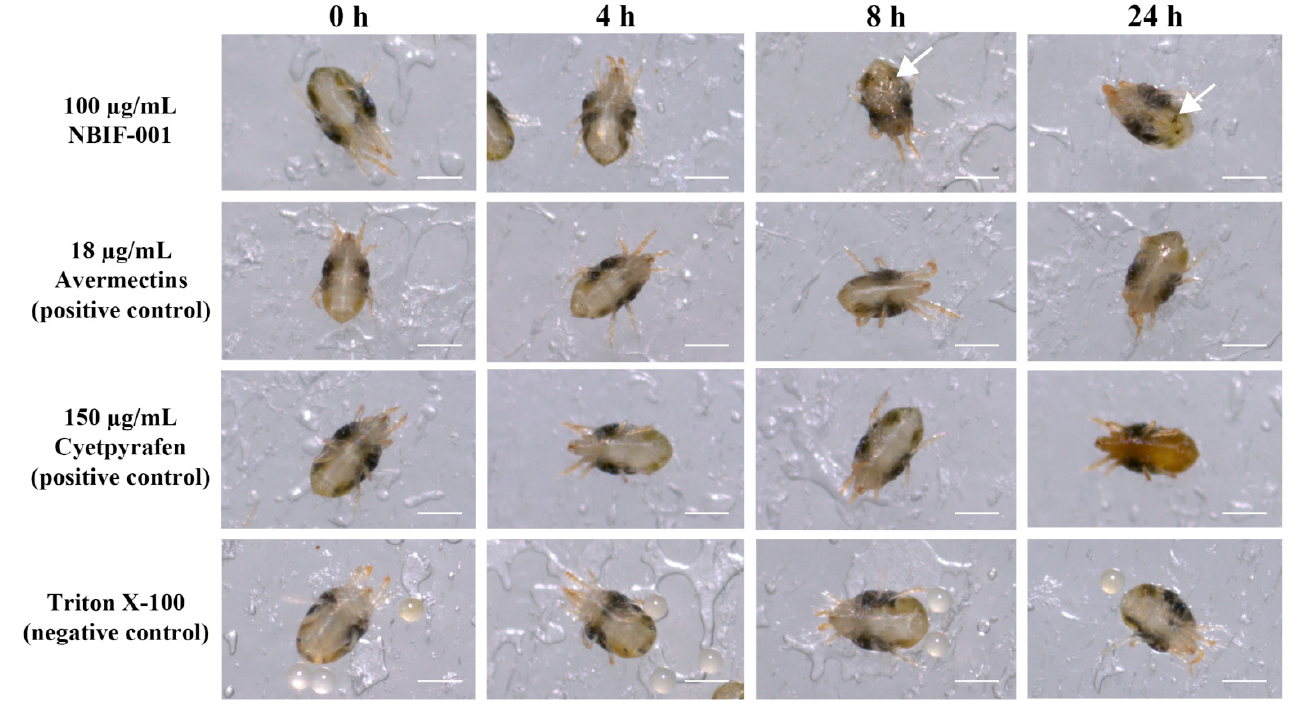
Figure 1. Female adult Tetranychus urticae (green) treated with 100.0 µ g/mL of NBIF-001 culture re-suspension, 18.0 µ g/mL avermectins, 150.0 µ g/mL cyetpyrafen (positive controls), and 0.05% Triton X-100 (negative control) for 24 h. Approximately 120 active adult mites were used for each individual treatment. Bars represent 250 µ m. Arrows indicate signs of body dehydration. Table 2. Acaricidal activity of fermentation-optimised Bacillus vallismortis NBIF-001 against Tetrany- chus urticae (green and red) and Panonychus citri